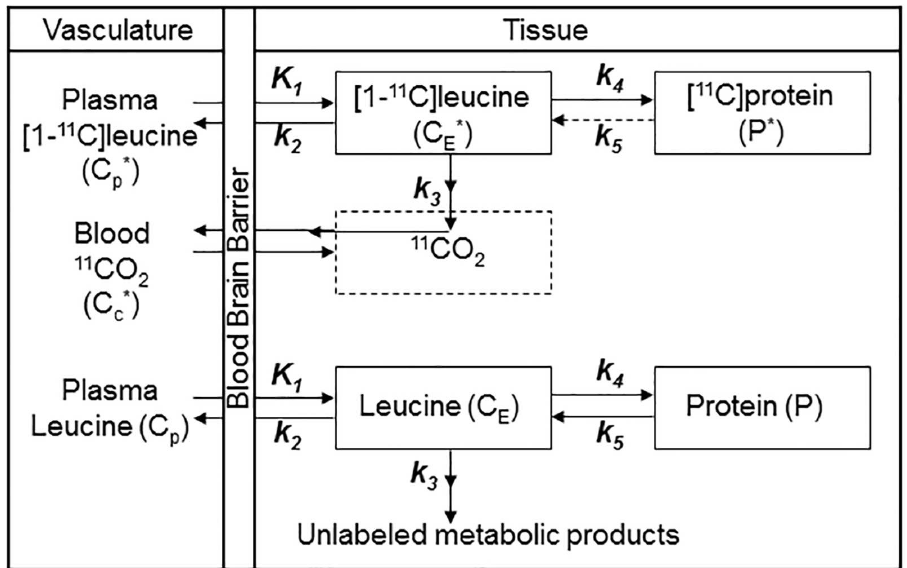
Fig 1. Homogeneous tissue kinetic model for L-[1- 11 C]leucine. Total concentration of 11 C ( C T (cid:3) ) includes free L- (cid:3) and P (cid:3) , respectively), plus activity in blood [1- 11 C]leucine and L-[1- 11 C]leucine incorporated into tissue protein ( C E ( V b C b (cid:3) , where V b is the fraction of the volume occupied by blood and C b (cid:3) is the concentration of activity in whole blood). Total 11 C also includes labeled products of L-[1- 11 C]leucine metabolism: 11 CO 2 and products of 11 CO